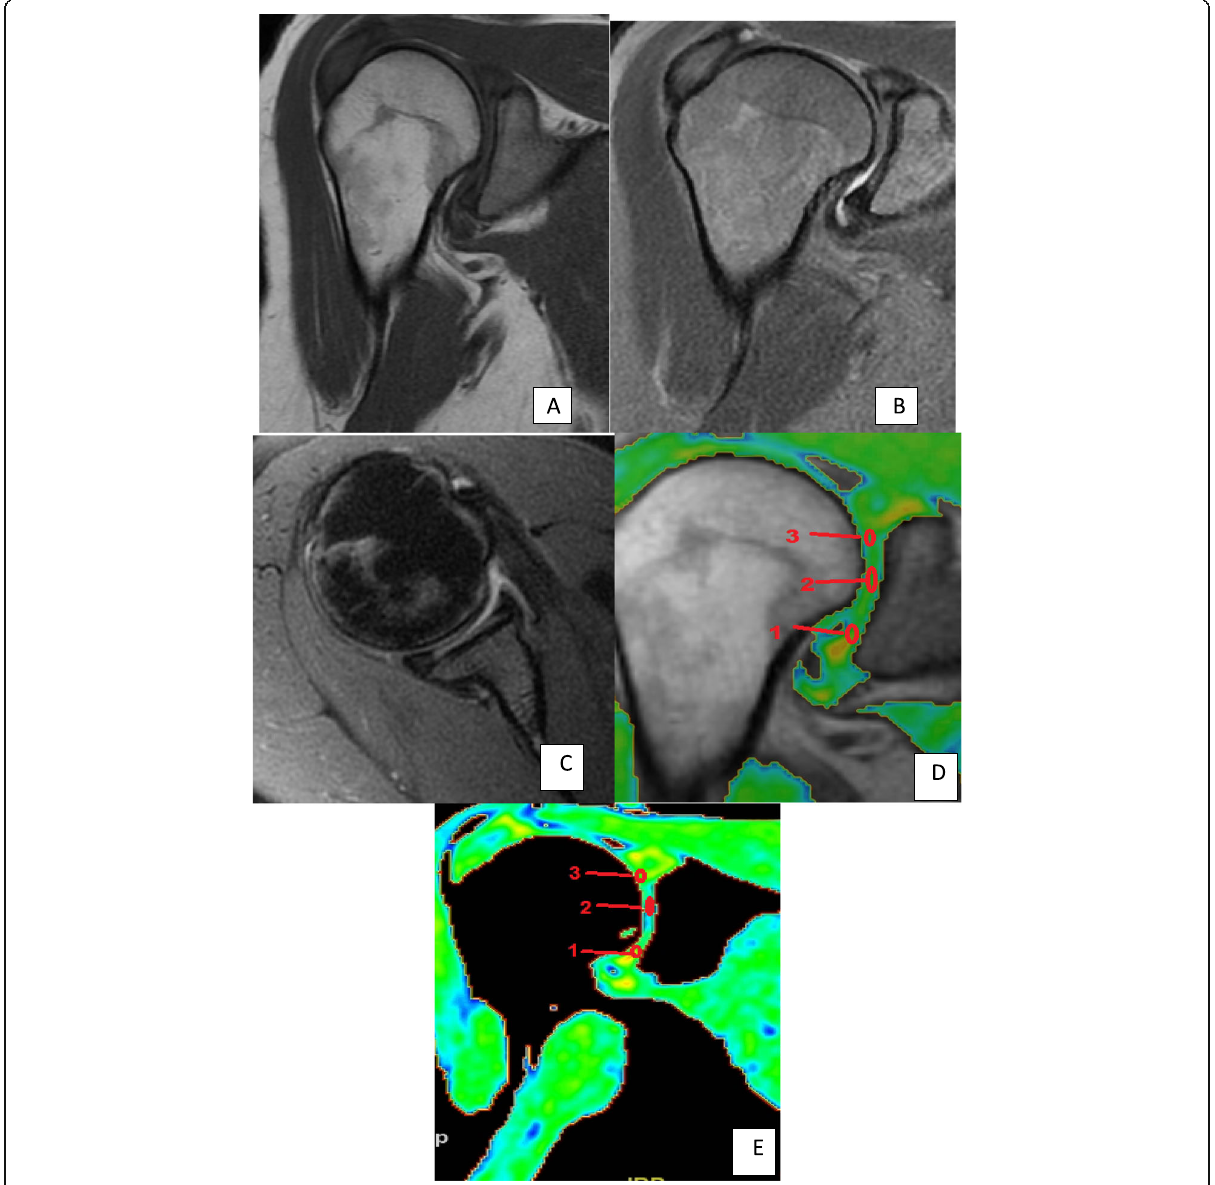
Fig. 5 a Coronal T1WI. b Coronal proton density (PD) WI. c An axial PD WI MRI showed osteoarthritic changes in the form of an irregular articular surface of glenoid, narrowed joint space, and minimal osteophytes( grade II). (C)T2 mapping and (D) processed image showed average T2 values 57.7 ms, 65.8 ms, and 72 ms at glenoid zone (1), mid zone (2), and humeral zone (3) respectively(red